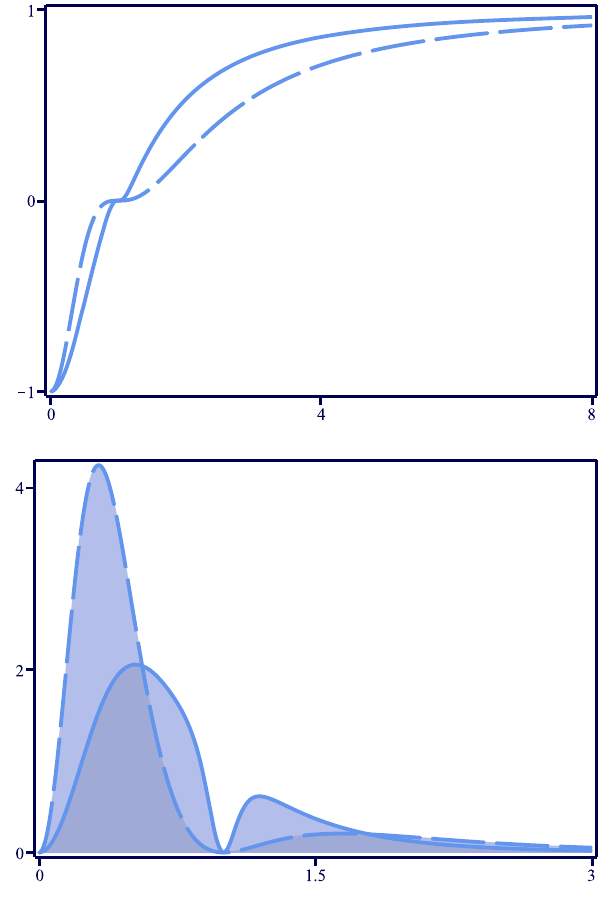
Fig. 3 The solution φ( r ) in Eq. (44) (top) and its energy density ρ 1 ( r ) in Eq. (45) (bottom), depicted for α = 2 (dashed line) and 10 (solid line)